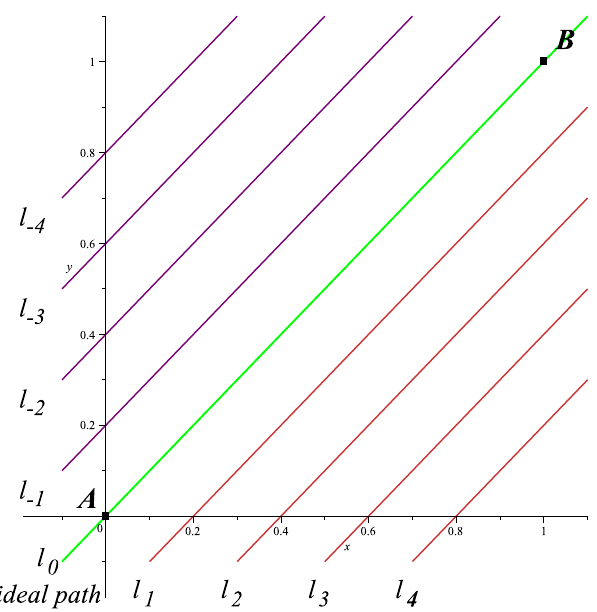
Figure 5. Auxiliary straight lines and ideal path for initial point A and goal position B